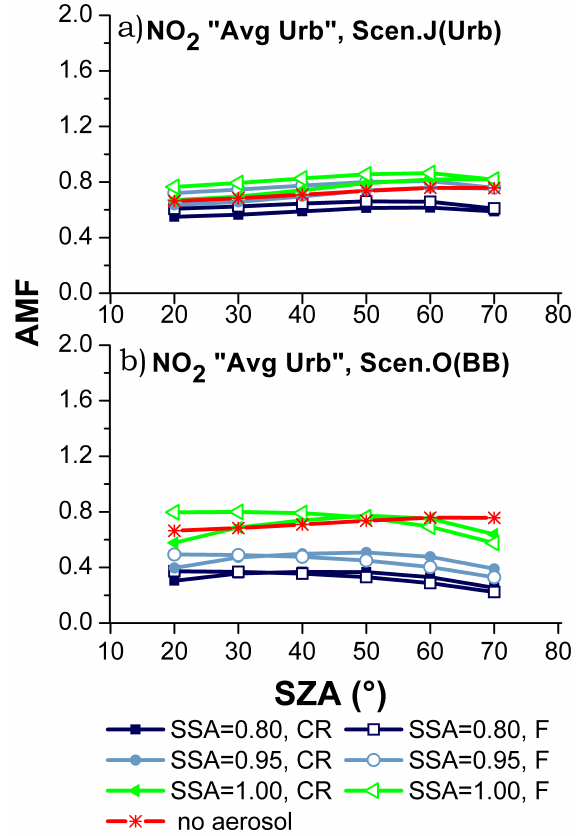
Fig. 12. NO 2 airmass factors for different single scattering albedo (SSA, ω 0 = 0.80, 0.95 and 1.00) for scenario (a) J and (b) O (urban NO 2 profile from CHIMERE with urban (Urb) and biomass burn- ing (BB) aerosol, respectively) calculated with the phase functions determined for coarse (CR) and fine (F) particles (optical properties taken from Creteil/Paris and Amazonian Forest/Brazil AERONET stations for scenario J and O, respectively). AMFs determined at 440nm, with surface albedo = 0.03, and the AOD = 0.40 (J) and 1.05